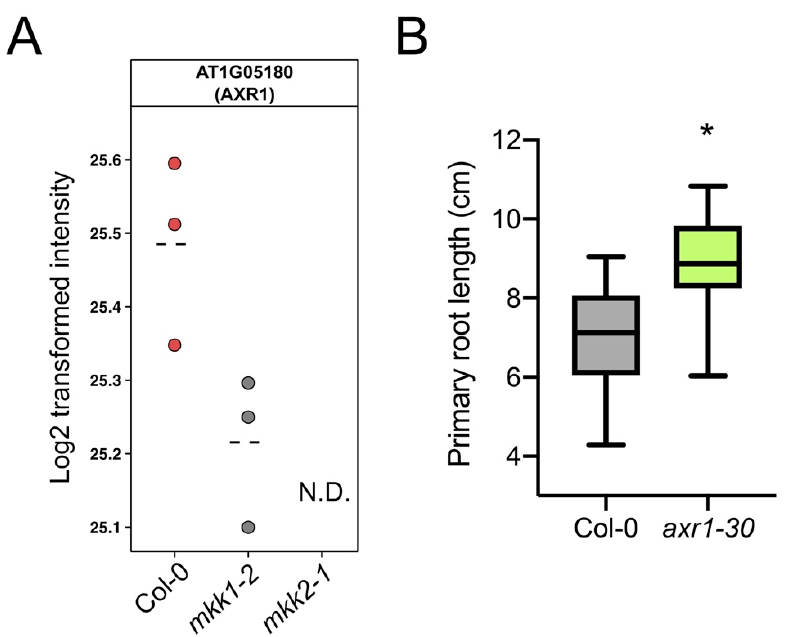
Figure 7. MKK1 and MKK2 affect AXR1 levels. ( A ) AXR1 protein profile in mkk1-2 and mkk2-1 . Dashed line indicates mean. Each dot is a biological replicate. N.D., not detected. ( B ) Primary root growth of axr1-30 (n = 31-35 seedlings) at 11 days after germination. Boxplots show average with Tukey-based whiskers. Statistical significance (Student’s t-test) comparing axr1-30 and Col-0 is indicated: * p < 0.05.